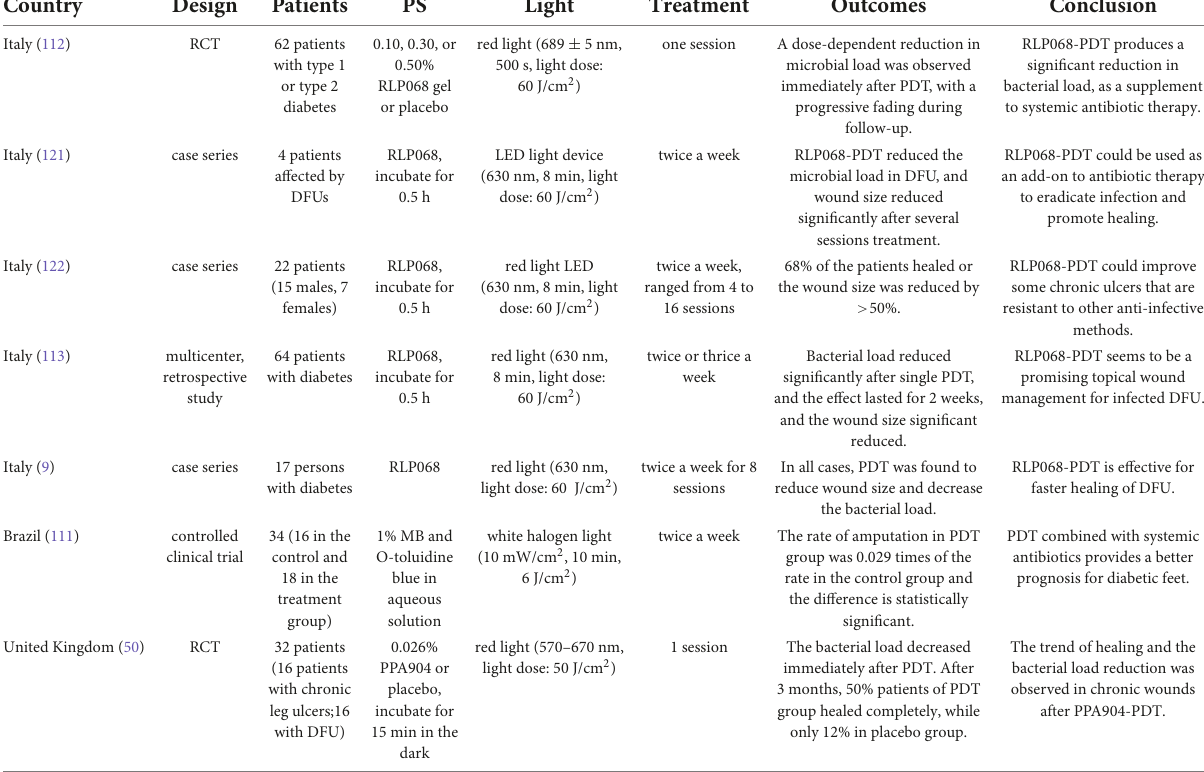
TABLE 2 Clinical studies involving PDT in DFU. Country Design Patients